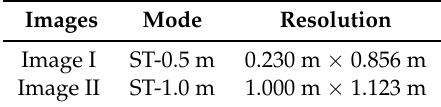
Table 1. Examples of the image resolution. ST: Spotlight.